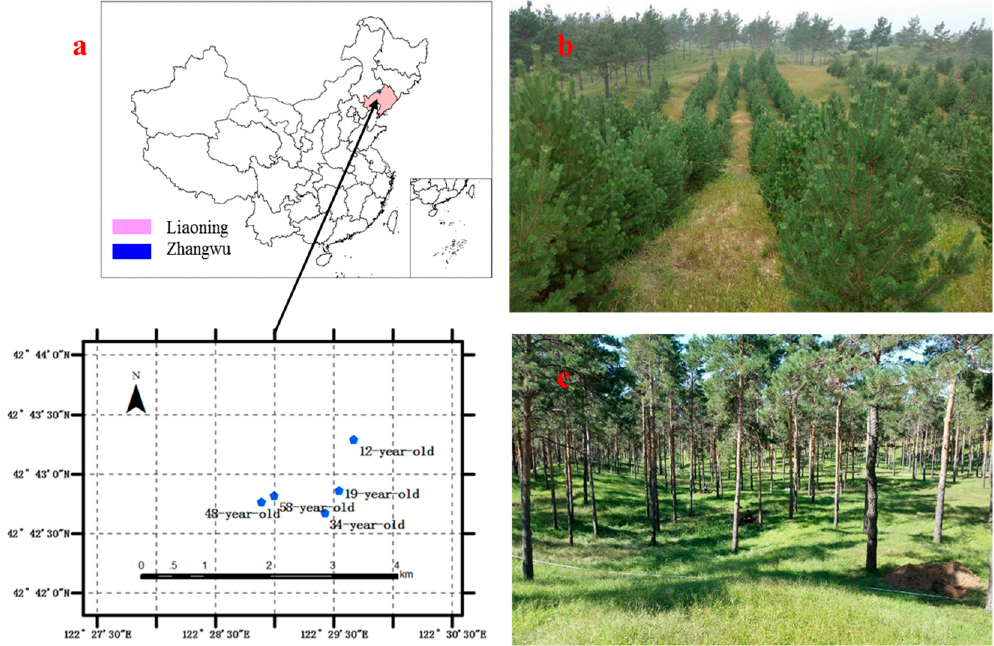
Figure 1. Location of the five Mongolian pine stands ( a ) and pictures of the 12-year-old ( b ) and 58-year-old ( c ) Mongolian pine stands.